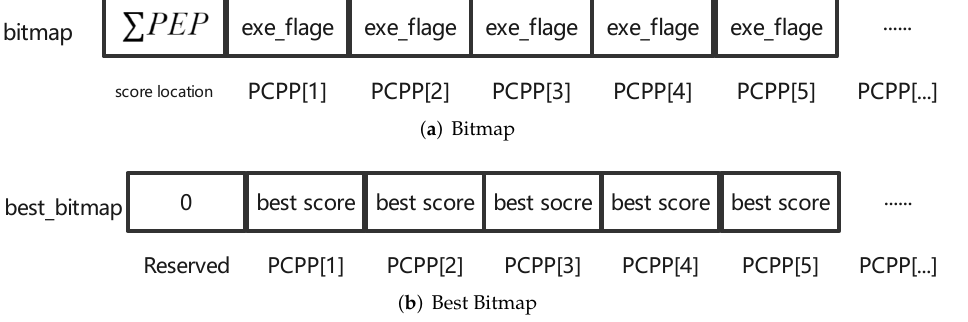
Figure 8. Format, Compare and Update of